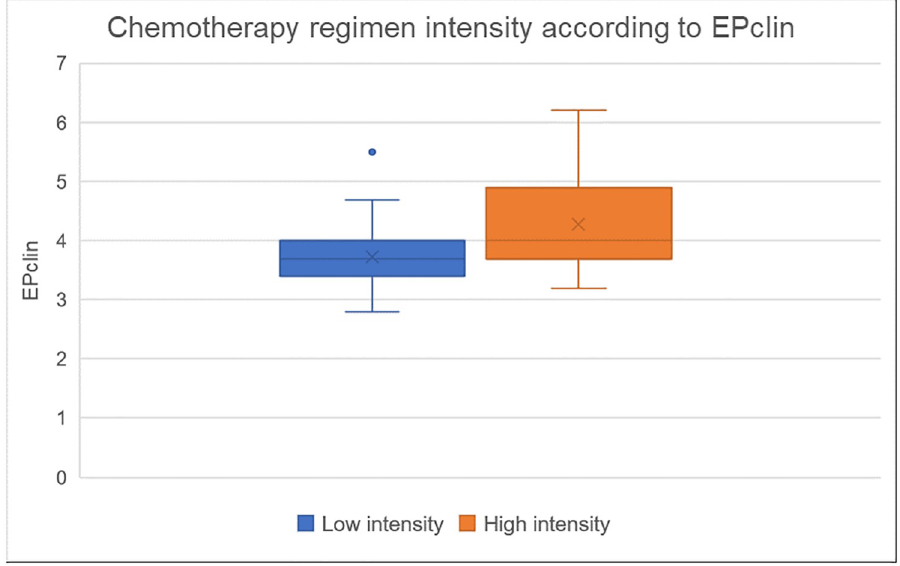
Fig 2. Chemotherapy regimen intensity according to